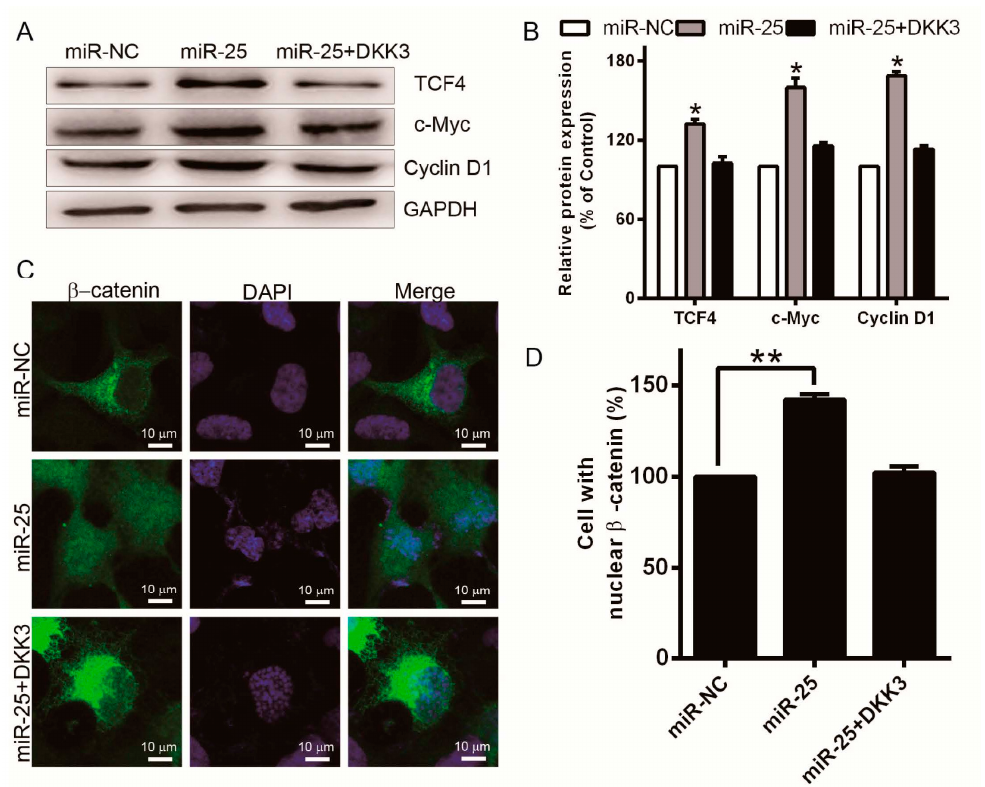
Figure 5. miR-25 inhibits nuclear translocation of β -catenin, and expression of TCF4 targets Cyclin D1 and c-Myc. ( A ) TCF4, Cyclin D1, and c-Myc level at the indicated points after miR-25 or miR-25, plus pcDNA-DKK3 transfection in MV3 cells was measured by Western blot. The level of GAPDH was emplored as the loading standard; ( B ) the protein levels were analyzed using the Quantity One software (Bio-Rad Laboratory, Inc., Hercules, CA, USA). The black histogram represents the optical densities of the signals quantified by densitometric analysis and represented as TCF4, c-Myc, or Cyclin D1 intensity/GAPDH to normalize for loading control; ( C , D ) MV3 were transfected with miR-NC, miR-25, or miR-25 plus pCDNA-DKK3. Localization of β -catenin was analyzed by immunofluorescence 48 h after transfection. 4 ′ ,6-Diamidino-2-phenylindole (DAPI) (blue) was used for nuclei staining. Scale bar = 10 μ m. * p < 0.05, ** p < 0.01.